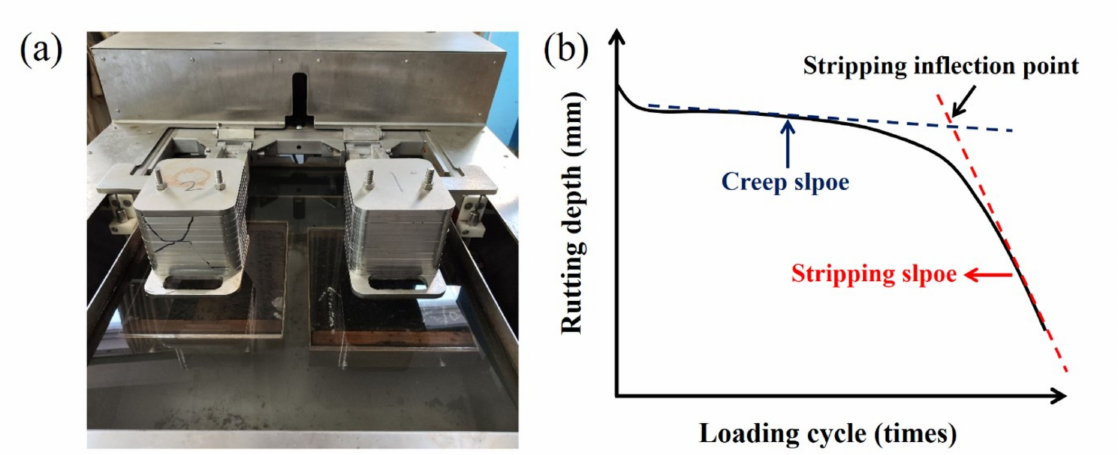
Figure 3. Testing device ( a ) and schematic diagram ( b ) of HWT